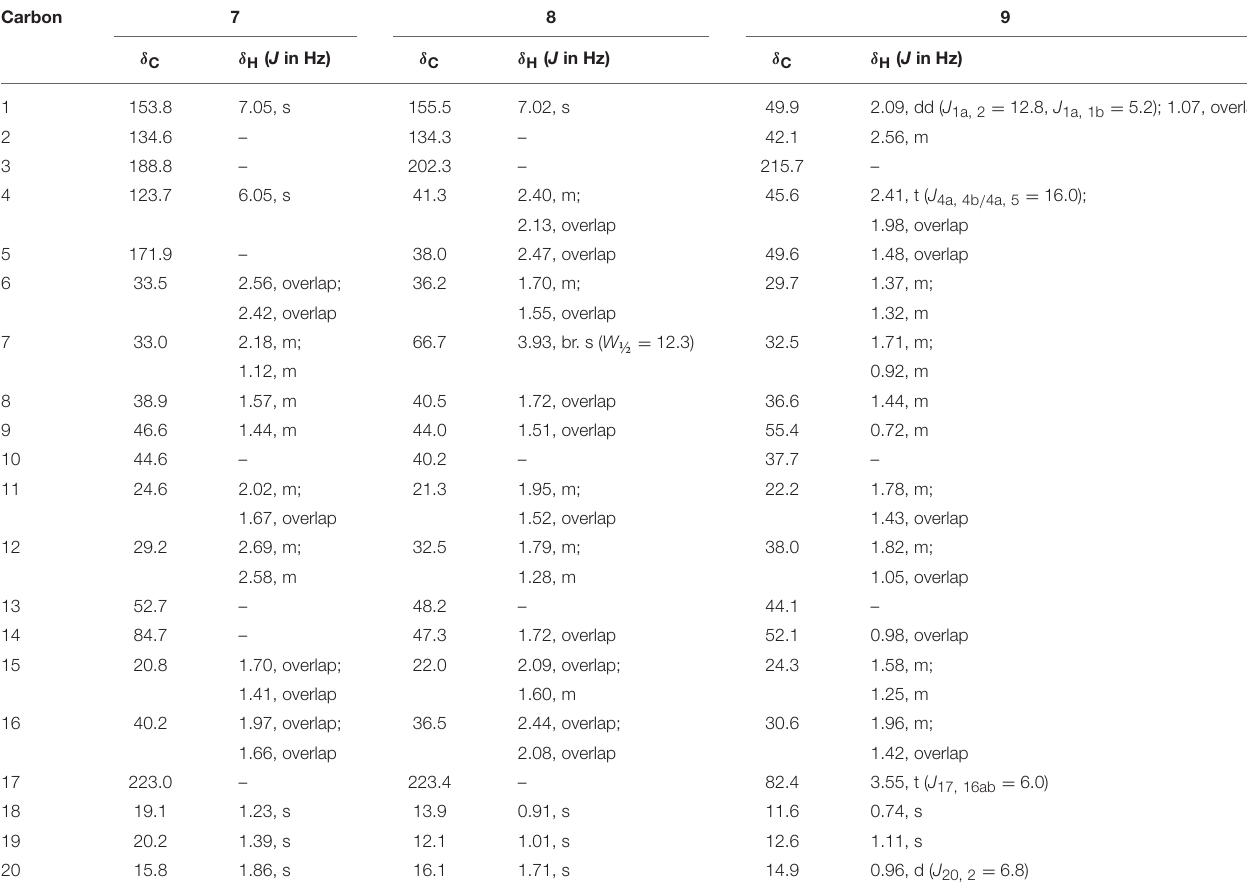
TABLE 3 | 13 C- and 1 H-NMR chemical shift data ( J and W 1 / 2 in Hz) of compounds 7 – 9 ( δ ppm).